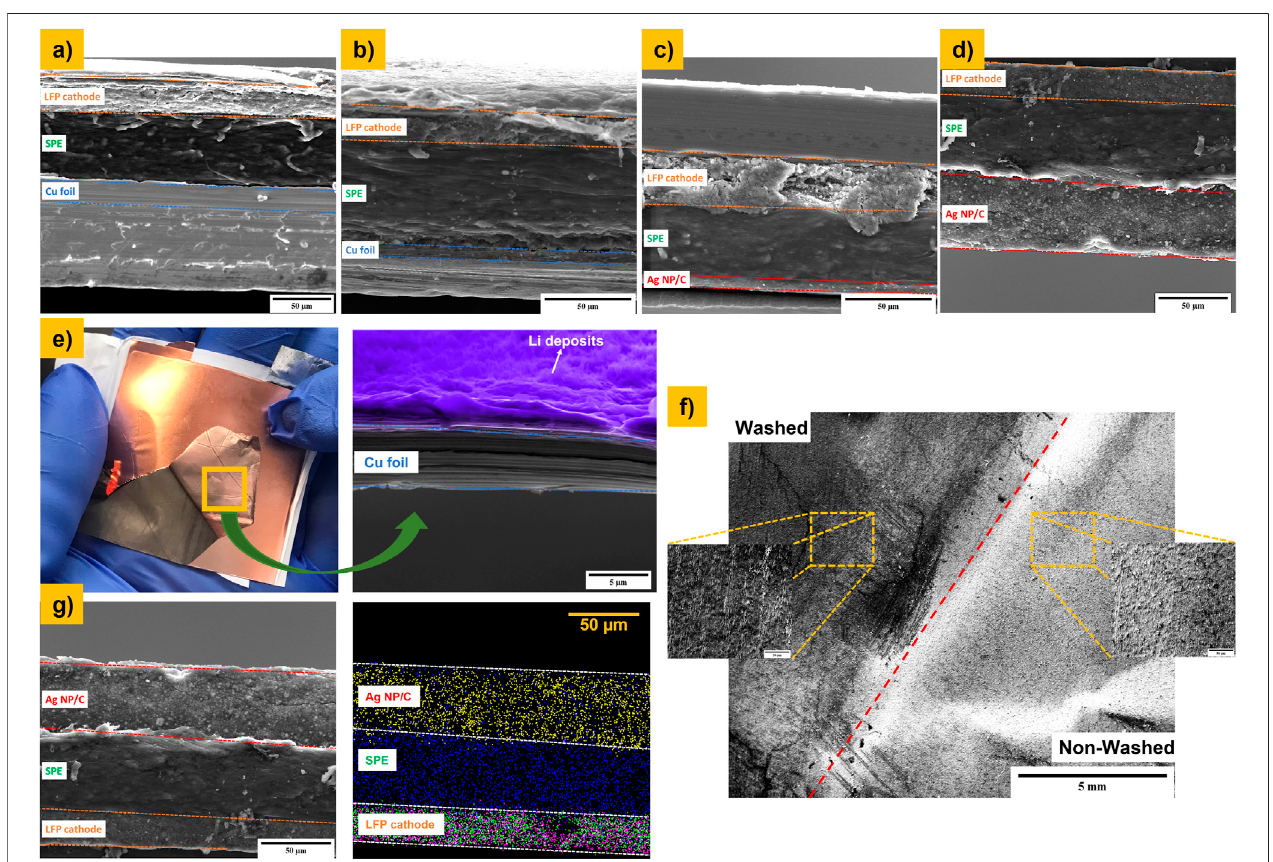
FIGURE 5 | SEM Cross section of different pouch cells before and after charging processing up to 3.8 V. (A) AF_01, (B) AF_02, (C) AF_03, and (D) AF_04; (E) photograph taken during the disassembling of “ AF_02 ” cell and the cross section of the Cu foil CC after charging the pouch cell up to 3.8 V; (F) top view SEM micrographsofCufoilCCrecoveredfrom “ AF_02 ” beforeandafterthewashingprocess;and (G) crosssectionandmappingof “ AF_04 ” cellaftertheion-millingprocess: Ag (yellow dots); S (blue dots); Fe (purple dots); and P (green dots).